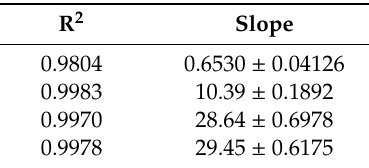
Table 4. Goodness of fit and slope characteristics for Figure